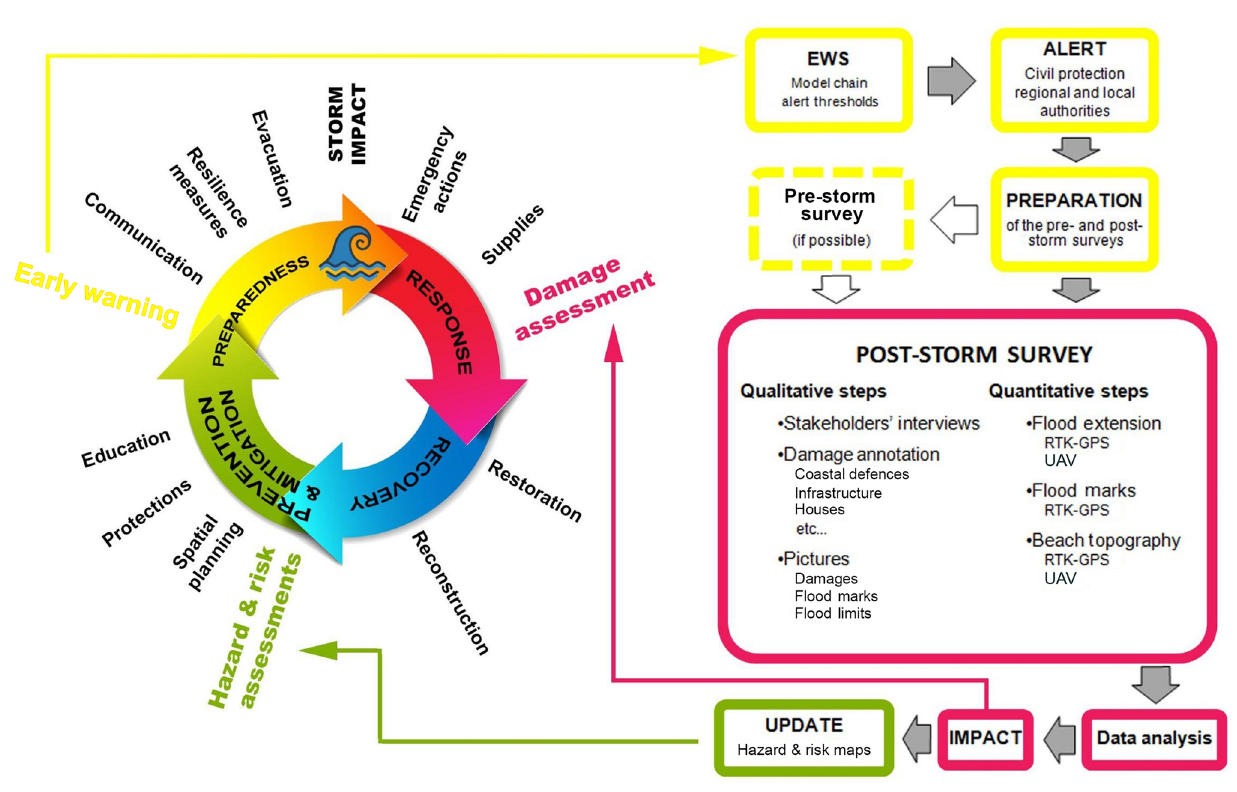
Figure 3. The quick-response protocol in the framework of the disaster management